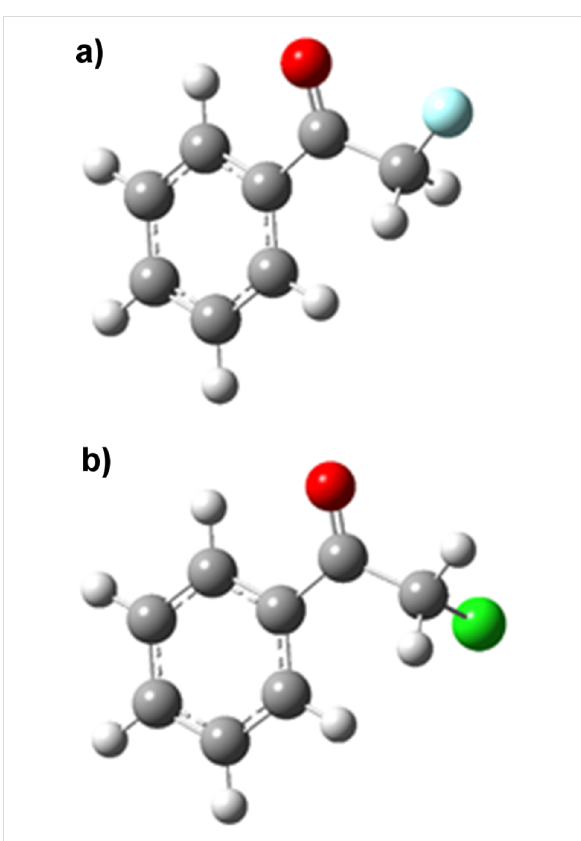
Figure 3: Most stable conformations of (a) α -fluoroacetophenone and (b) α -chloroacetophenone in ethanol.